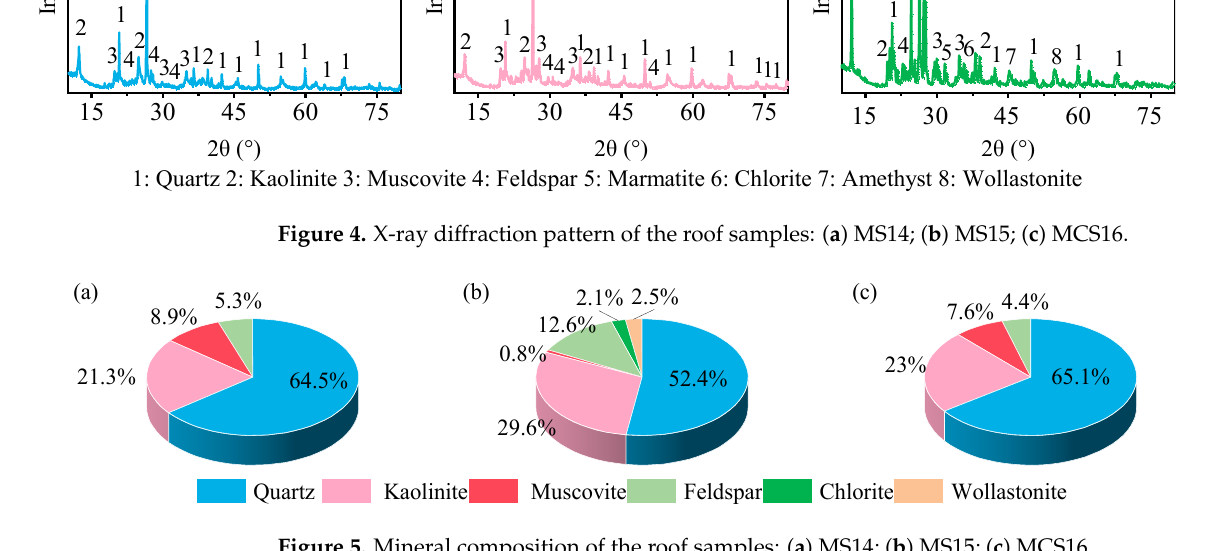
Figure 5. Mineral composition of the roof samples: ( a ) MS14; ( b ) MS15; ( c ) MCS16.